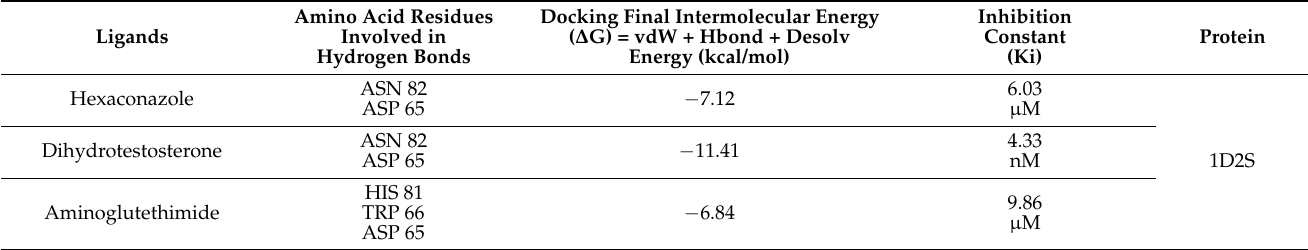
Figure 3. SHBG molecular interaction pattern with aminoglutethimide.